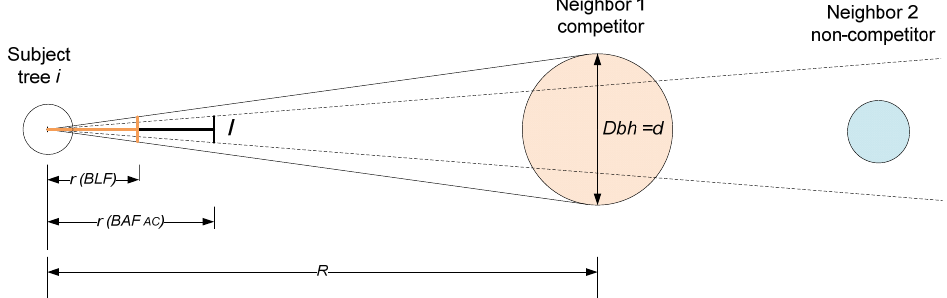
Figure 1. An angle stick gauge of a predetermined length r ( BAF AC ) from the peep sight and a crossarm of predetermined width l is used to determine the sample size of neighbors in the competition index for the subject tree. Neighbor 1 is a competitor tree because it subtends an angle that is larger the critical angle defined by the basal area factor of angle count sampling ( BAF AC ). Conversely, Neighbor 2 is not included in the sample and is considered a non-competitor. BAF AC , angle count basal area factor; BLF, borderline factor or ( d / R) 2 /4. (Adapted from